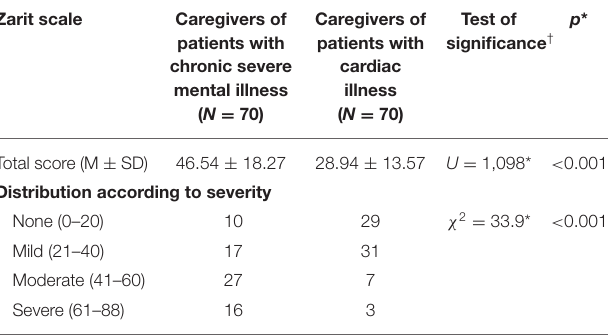
TABLE 2 | Stress burden in caregivers of patients with severe mental illness and patients with cardiac illness (ischemic cardiac disease complicated with chronic heart failure).